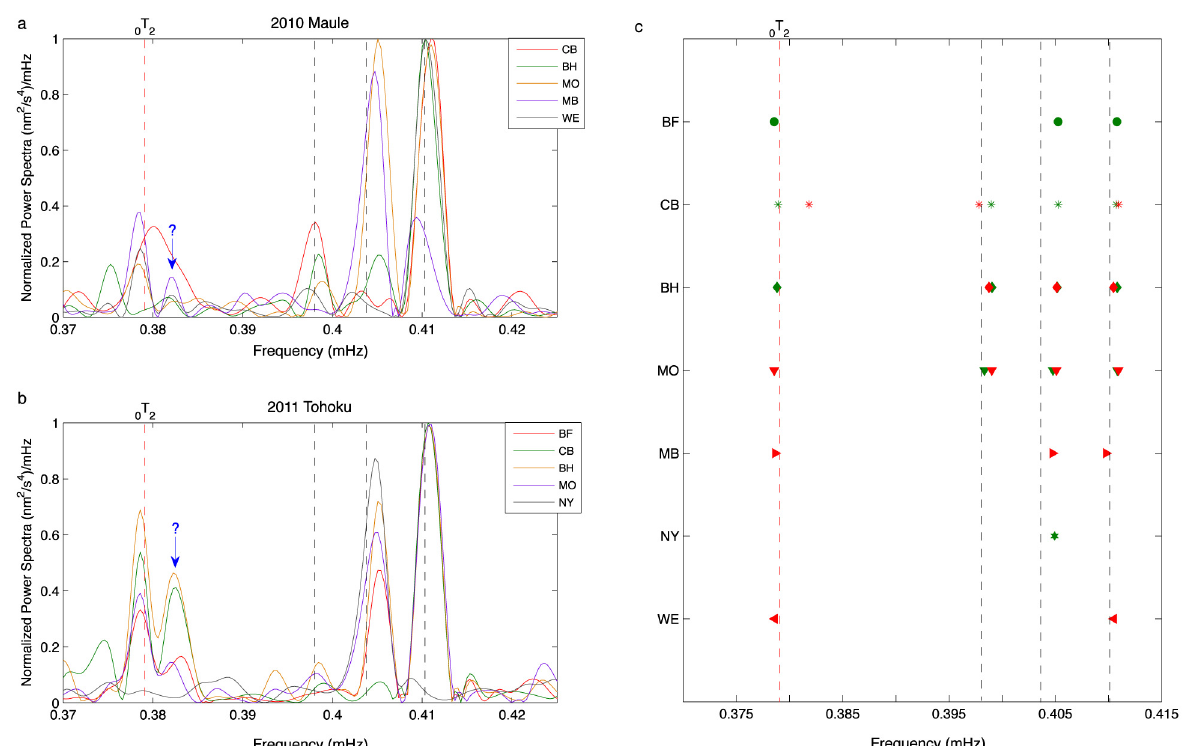
S based on the residual gravity time series after the 2010 and 2011 events. (a) The results of 5 residual grav- Figure 5. The power spectra of 2 1 ity time series after the 2010 Maule event; (b) the results of 5 residual gravity time series after the 2011 Tohoku; (c) the estimated frequen- cies from different series. The PREM predictions are denoted by vertical dashed lines (for T , the value is from Dziewonski and Anderson [1981], denoted by red vertical dashed line). denoted by black vertical dashed lines; for 0 2 Rosat et al. PREM* S 2 1